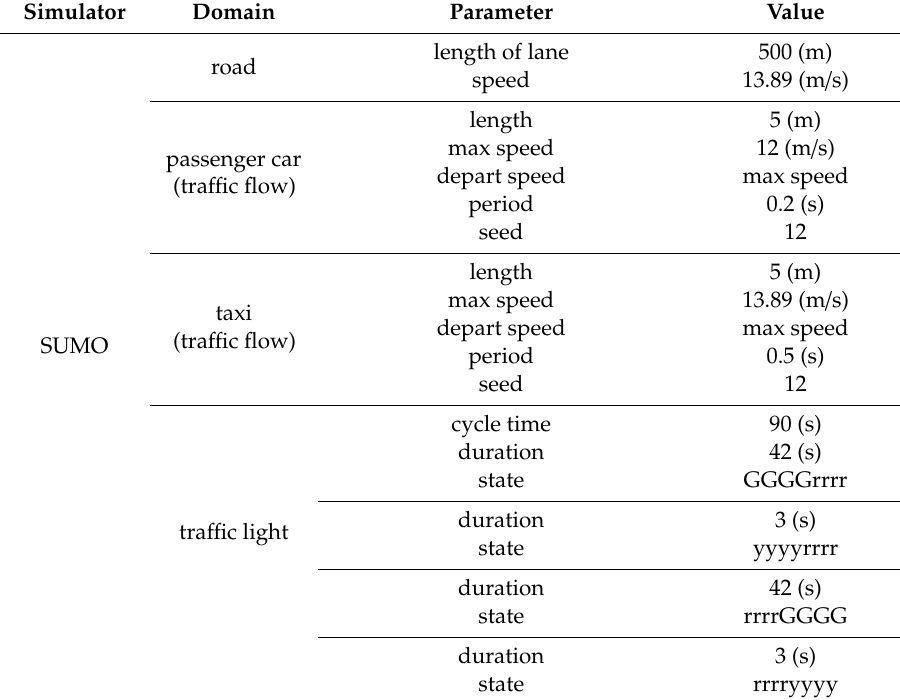
Table 3. Simulation